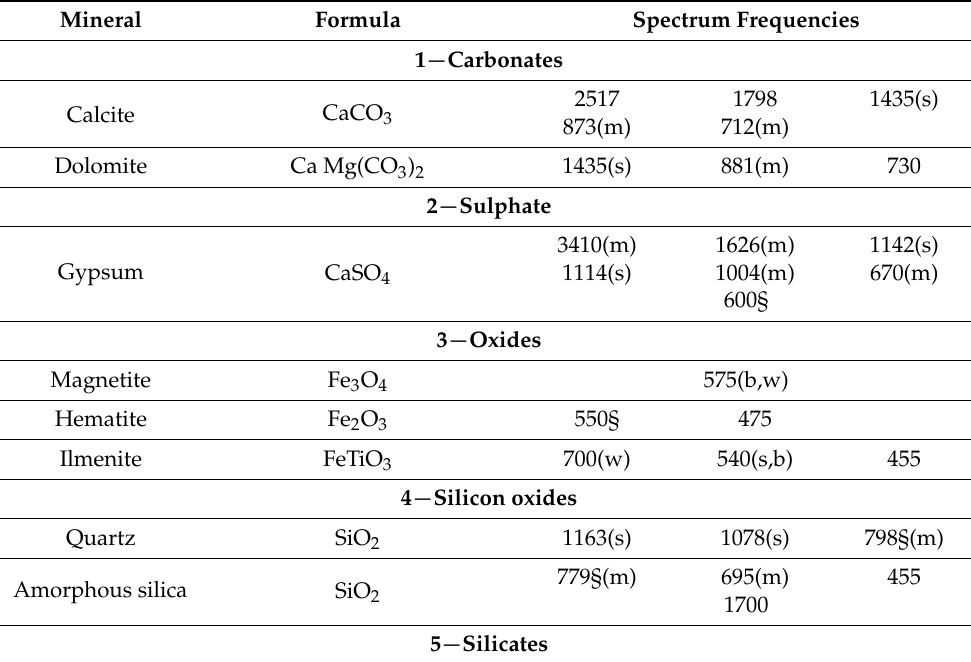
Table 1. Infrared spectrum frequencies of common